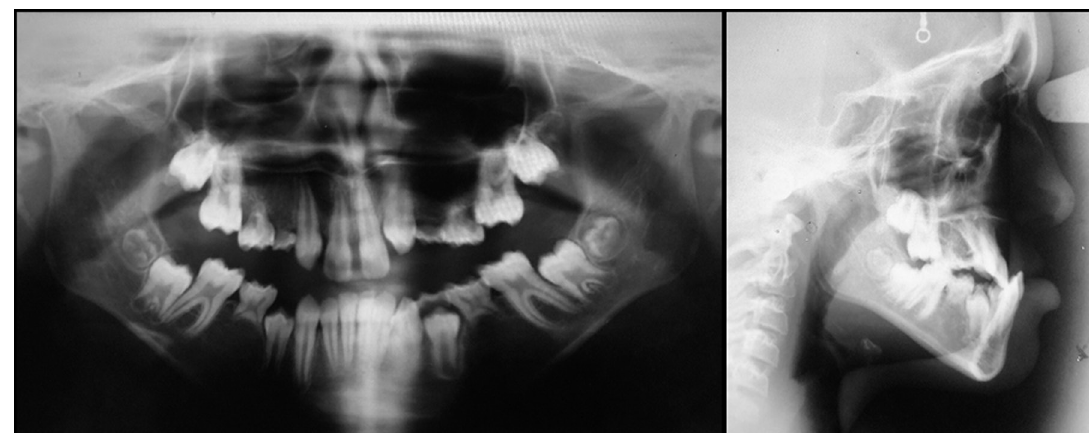
Figure 2. Pre-treatment dental casts.